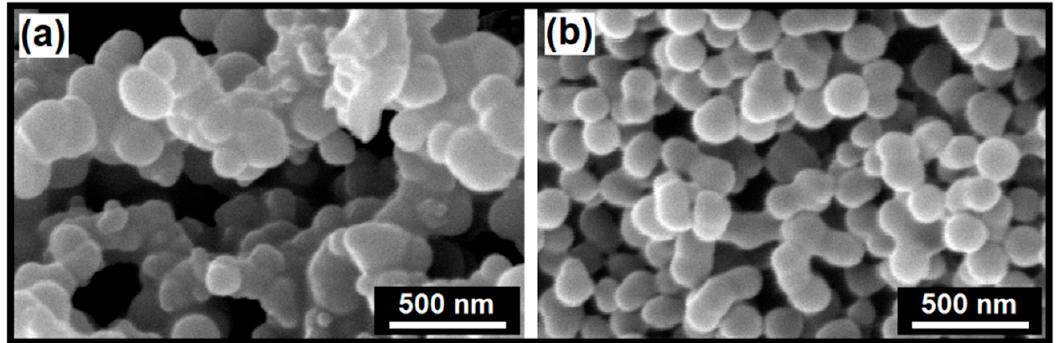
Figure 3. SEM images of the as-prepared products via hydrothermal method without ( a ) and with ionic liquids (ILs) ( b ).